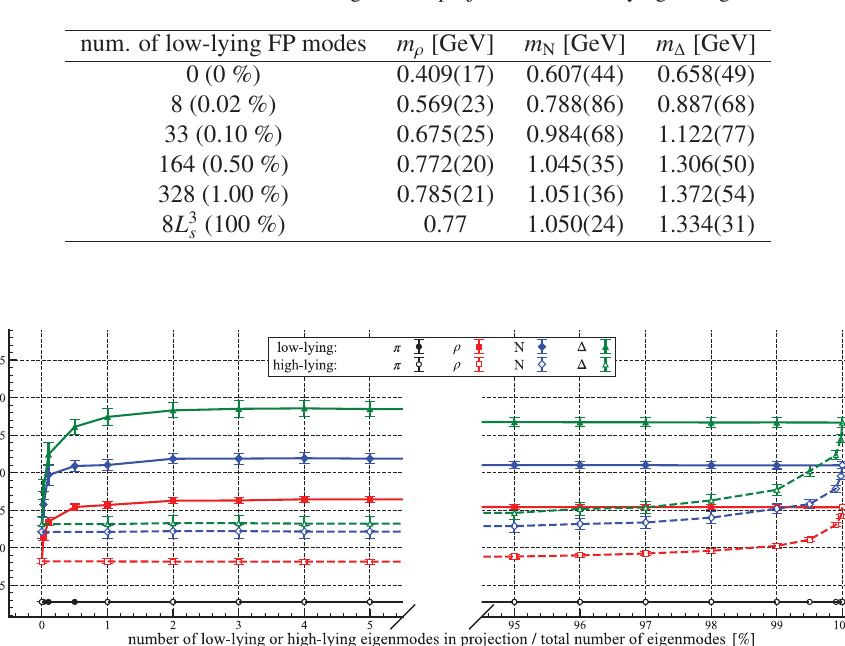
Figure 3. Hadron masses under the eigenmode projection in GeV unit plotted against the number of low-lying or high-lying FP eigenmodes in the projection. Pion mass m π = 0 . 14GeV is used to set the physical hopping parameter for each measurement. The lattice spacing a = 0 . 1051(15)fm is used to set the scale. The solid and dashed lines are connecting adjacent data points for